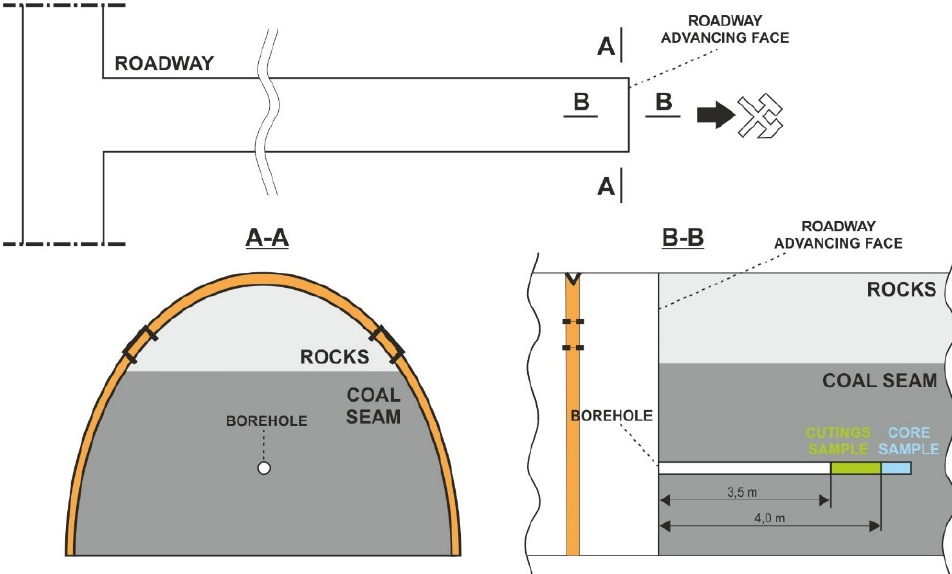
Figure 2. Coal sampling locations for testing.